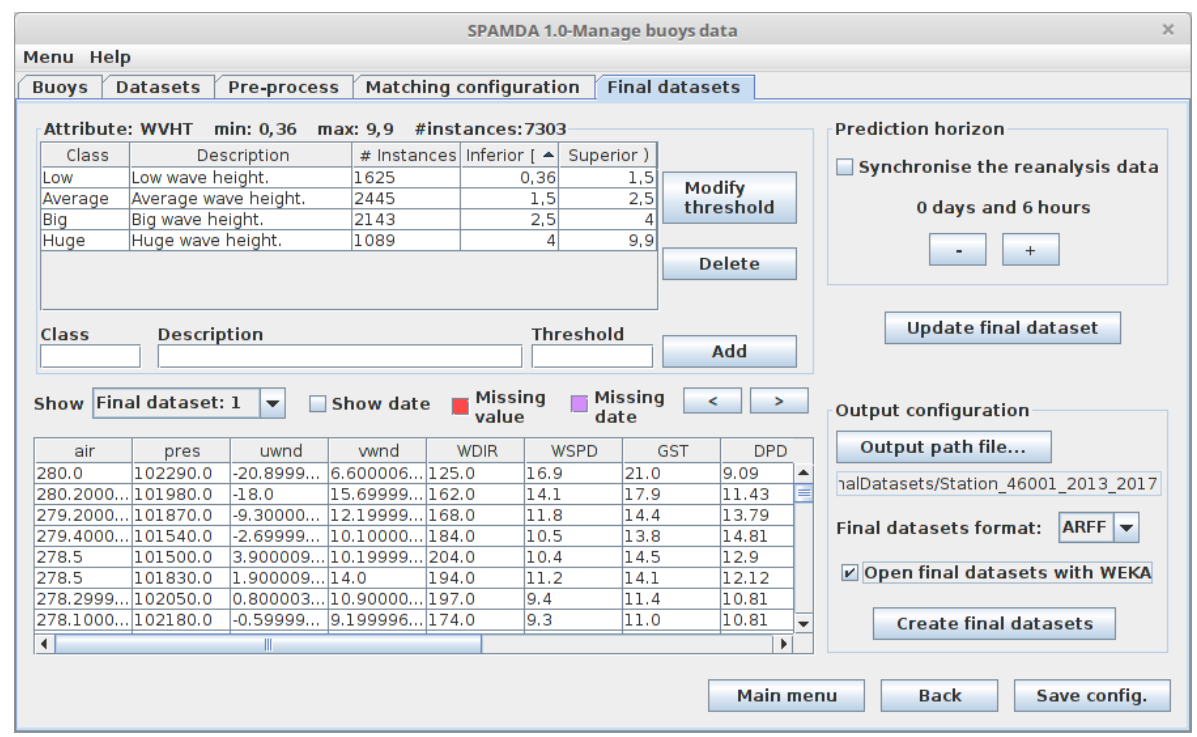
Figure 20. Final datasets tab: content of the final dataset created after data integration and discretisation of the output variable in four